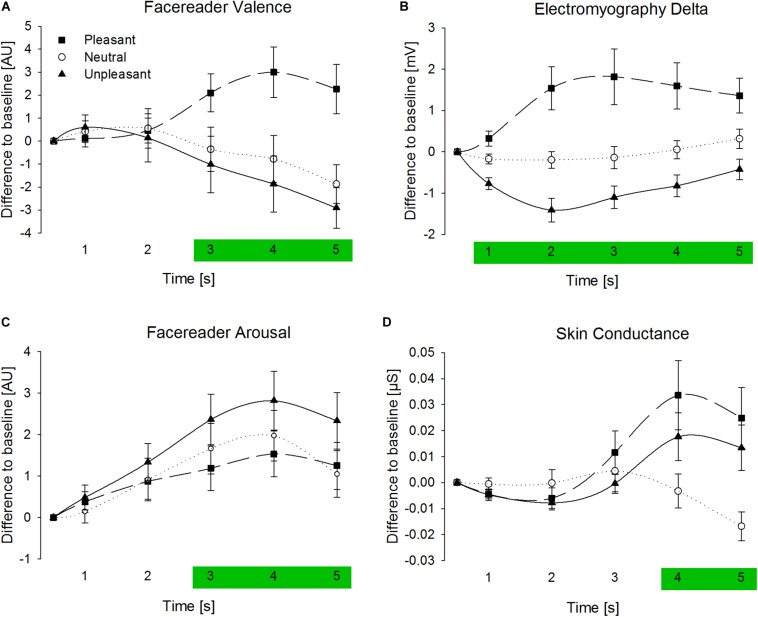
Averaged signals of Facereader Valence (A) Electromyography Delta (B), Facereader Arousal (C), and Skin Conductance (D) separate for time windows in seconds after picture onset (three seconds stimulus presentation) and stimulus category (difference to baseline in Arbitrary Units [AU], millivolt [mV], or micro Siemens [μS]). Error bars are standard errors of the mean. Green areas highlight time windows with significant stimulus category effects.